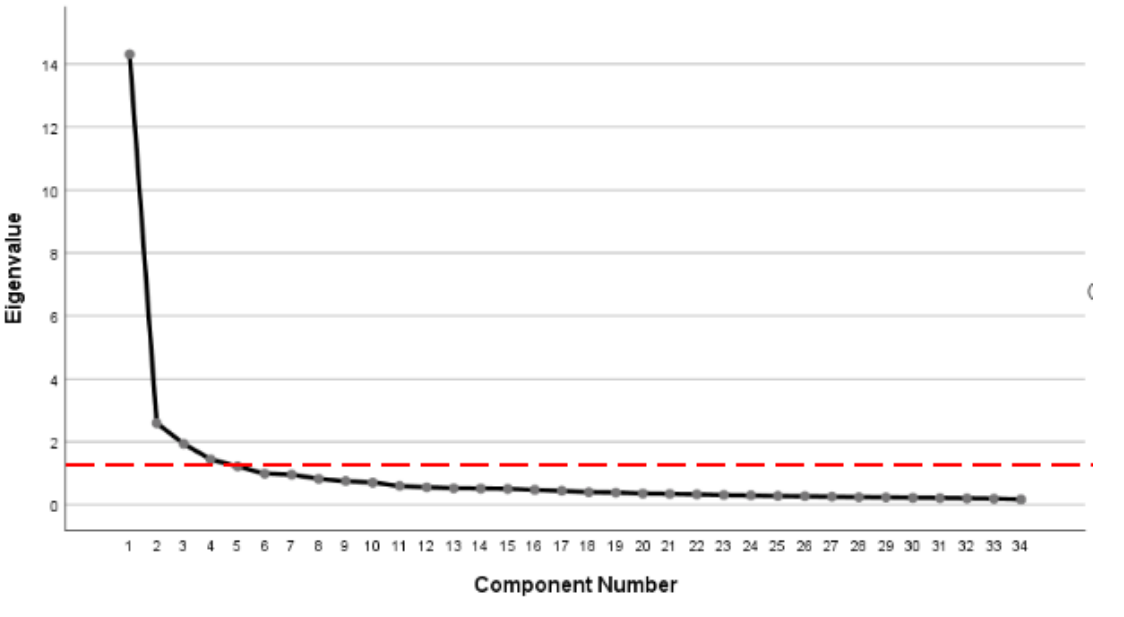
Figure 2. Number of components.